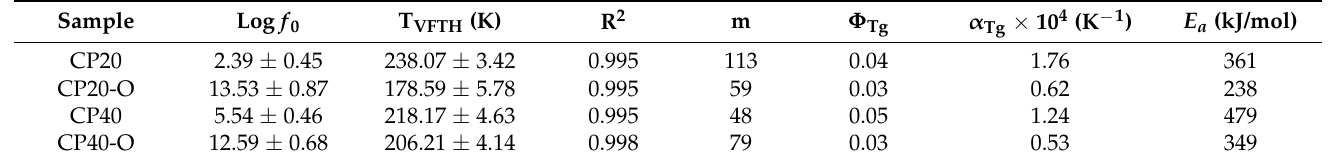
Table 5. Parameters for the VFTH model and derived parameters for the study of the α melting relaxation of the modified oriented and unoriented